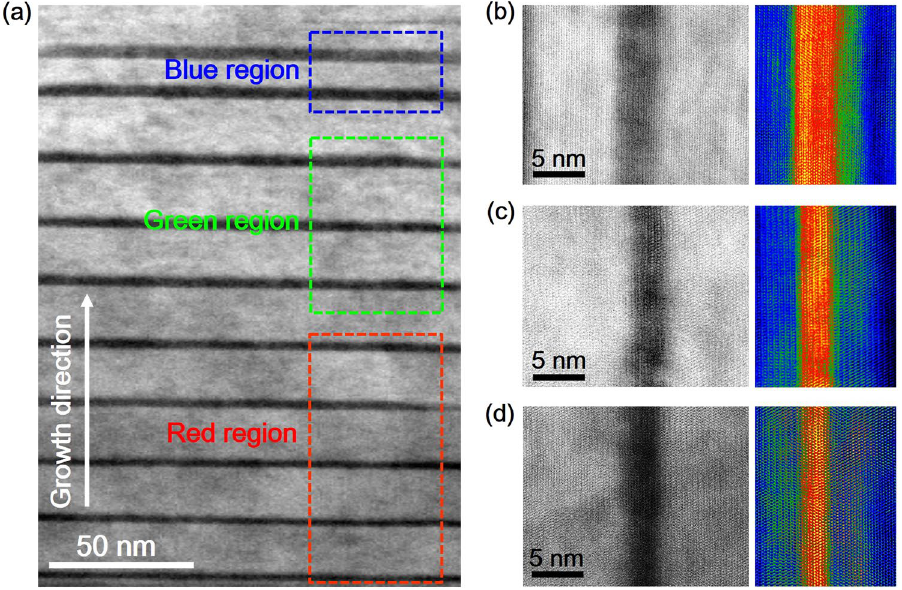
Figure 2. ( a ) Cross-sectional TEM image of the WLED with blue, green, and red QWs. (Left) STEM and (right) CCM-TEM images of the ( b ) blue, ( c ) green, and ( d ) red QWs, wherein red and blue indicate high and low Ga:In ratios,